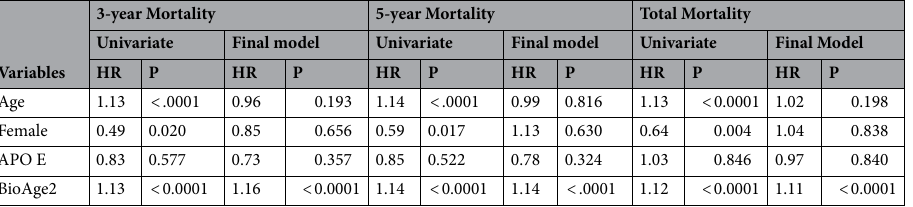
Table 5. Association of BioAge2, 3-Year, 5-Year and total all-cause Mortality: The Rotterdam Study, 2002– 2012.